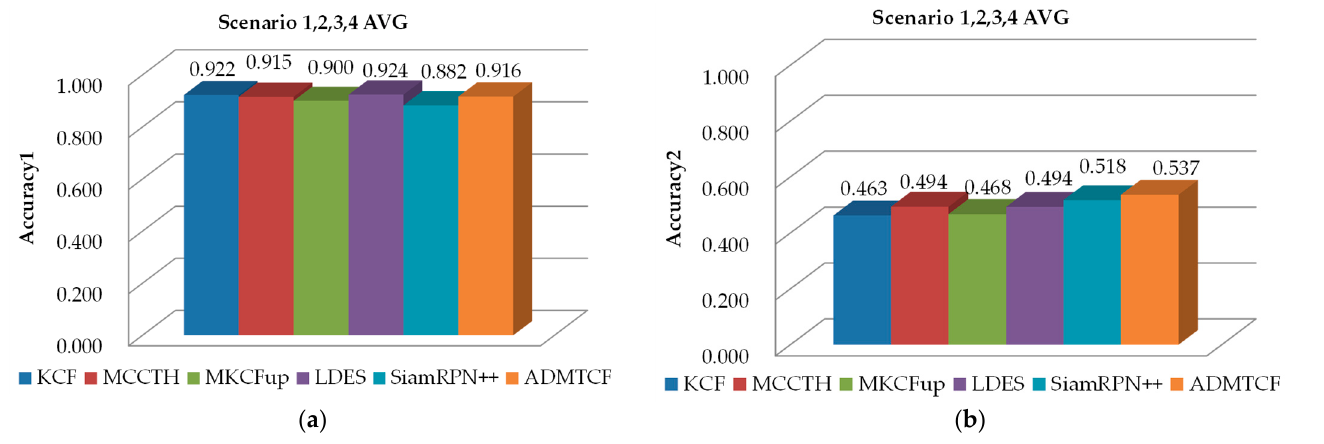
Table 4. Tracking accuracy using Metrics-2.